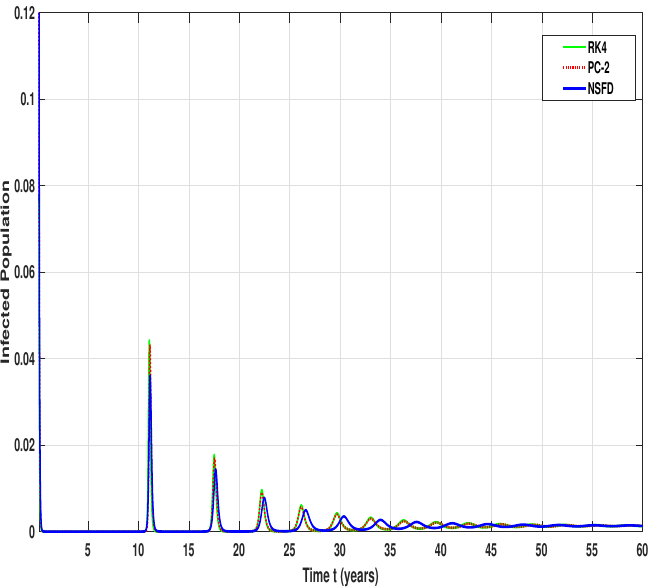
Figure 3. The numerical results of system (2) using the P-C schemes, NSFD schemes with h = 0.01 and RK4 with h = 0.005 following parameter values ( R 0 > 1 ) and I.C. S 0 = 0.24, I 0 = 0.007, R 0 = 0.753, β = 123, µ = 0.04, ν = 24.